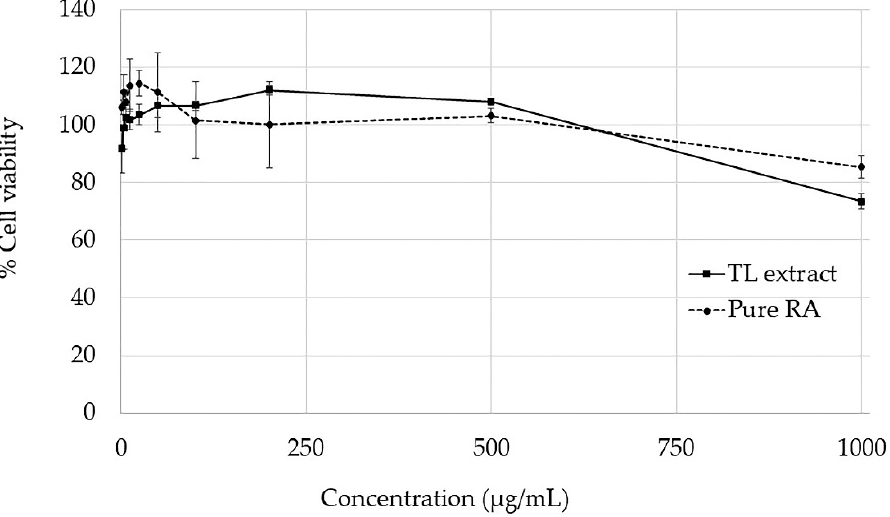
Figure 3. Cytotoxicity of the TL water extract and pure RA was investigated on Caco ‐ 2 cells after incubation at 37 °C for 24 h determined by the 3 ‐ (4,5 ‐ dimethylthiazol ‐ 2 ‐ yl) ‐ 2,5 ‐ diphenyltetrazolium bromide (MTT) assay . The data represent the mean ± SD from three replicates .